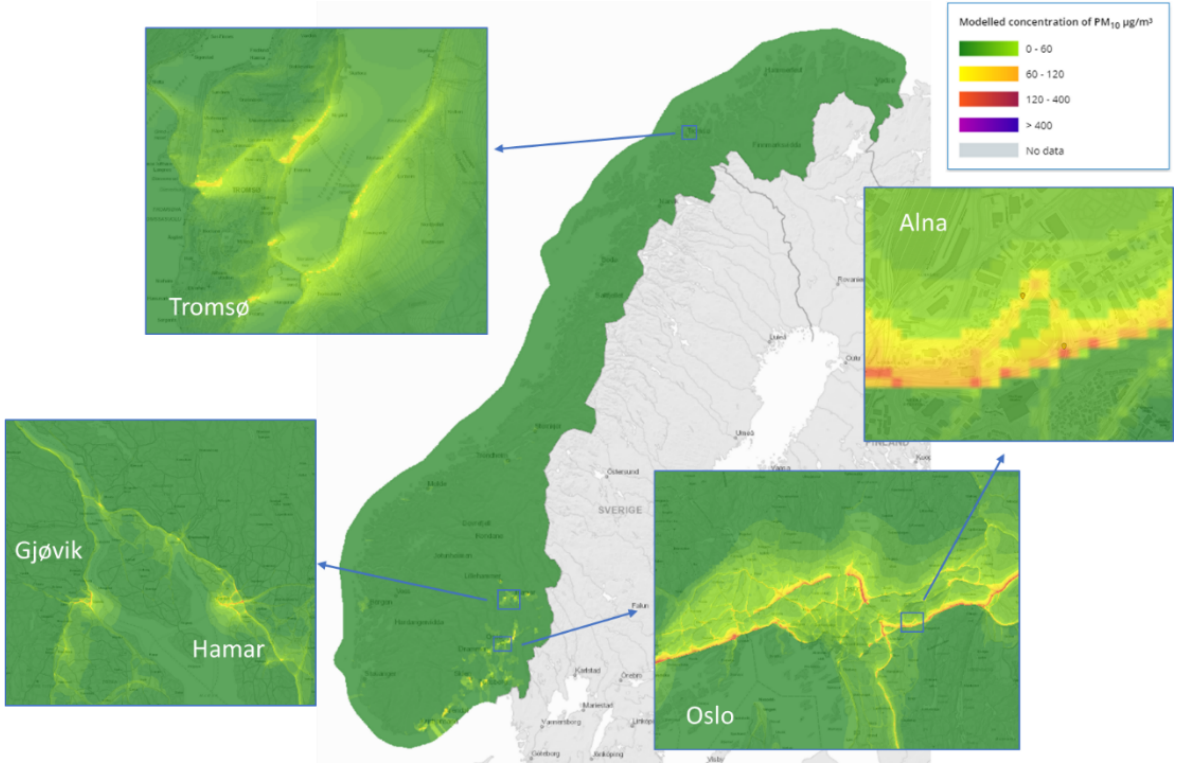
Figure 7. Example maps of PM 10 concentrations taken from the forecast on 24 February 2020 at 18:00UTC. The resolution in populated city regions is 50m. High PM 10 concentrations along roads are mainly the result of road dust emissions (©